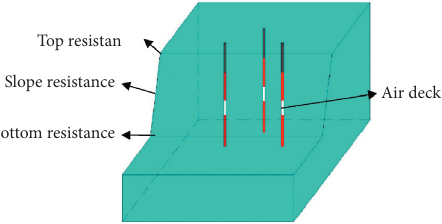
Figure of stress attenuation from absolute zero time